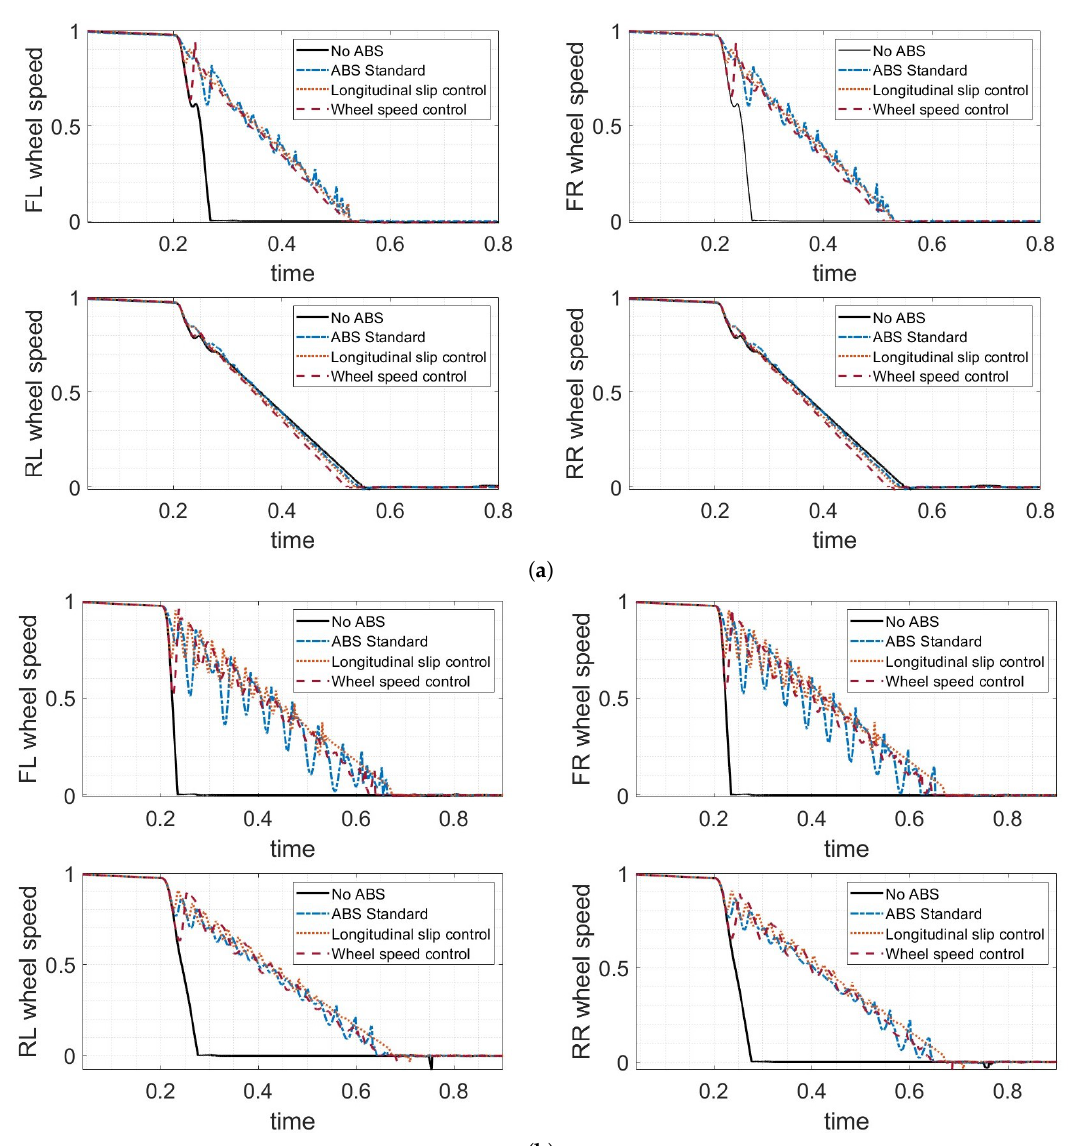
Figure 8. Wheel angular speed in longitudinal braking from 130 to 0 km/h with and without ABS . ( a ) Dry surface of friction level equal to 1. ( b ) Wet surface of friction level equal to